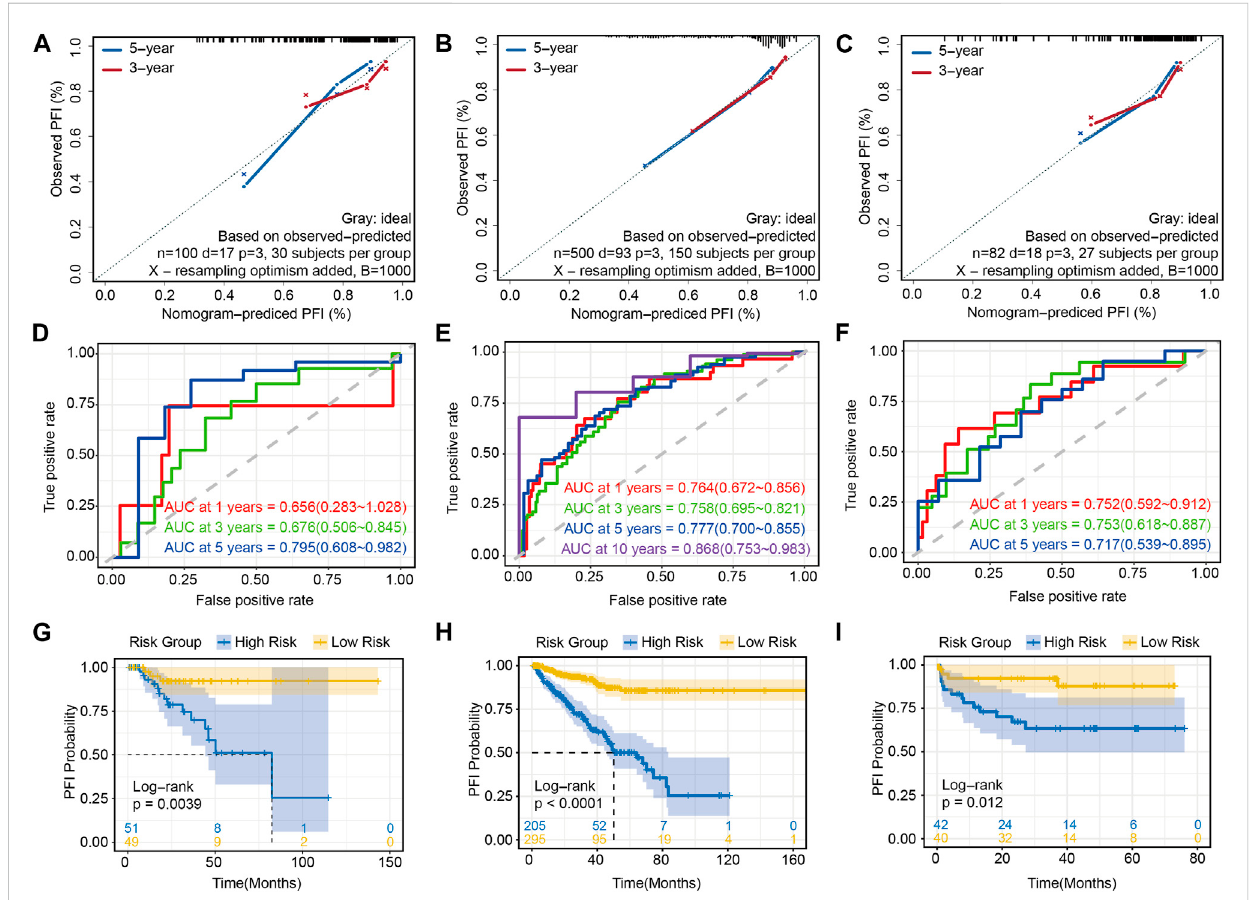
FIGURE 5 Validations ofpredictionoftheriskprognosticsignature:calibrationcurveshowingthatthepredictivePFI fi ttheactualPFIwellat3and5yearsin (A) theinternalvalidationset, (B) thewholeTCGA-PRADand (C) theexternalvalidationset.ROCcurvesshowingthePFIpredictionoftheriskmodelin (D) the internal validation set, (E) the whole TCGA-PRAD and (F) the external validation set. Univariate regression analysis of the risk score in (G) the internal validation set, (H) the whole TCGA-PRAD and (I) the external validation